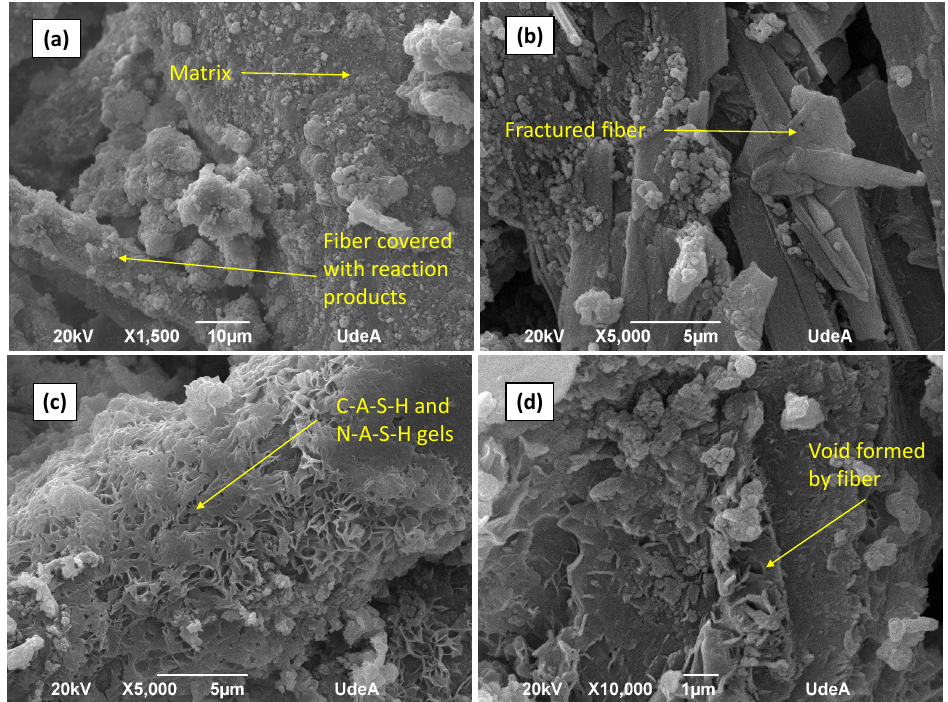
Figure 14. SEM images of alkali-activated cement combinations using Activator 3; ( a ) and ( b ) Act.3—0%; ( c ), Act.3—15% and ( d )